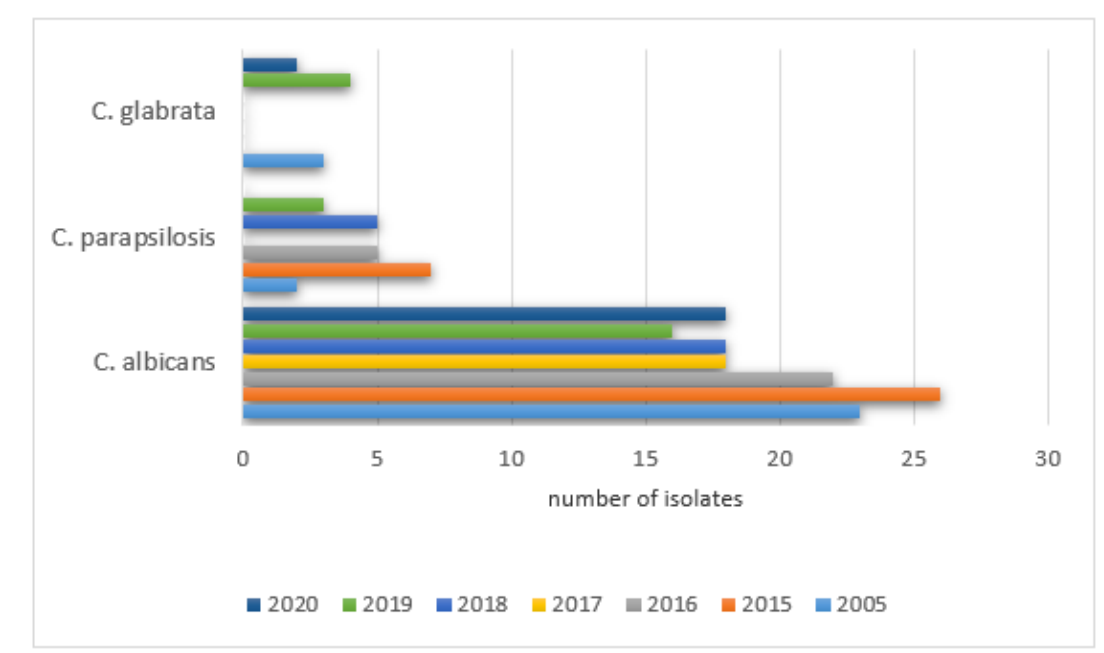
Figure 8. Most frequently isolated yeast species from samples collected in the NICU each year.